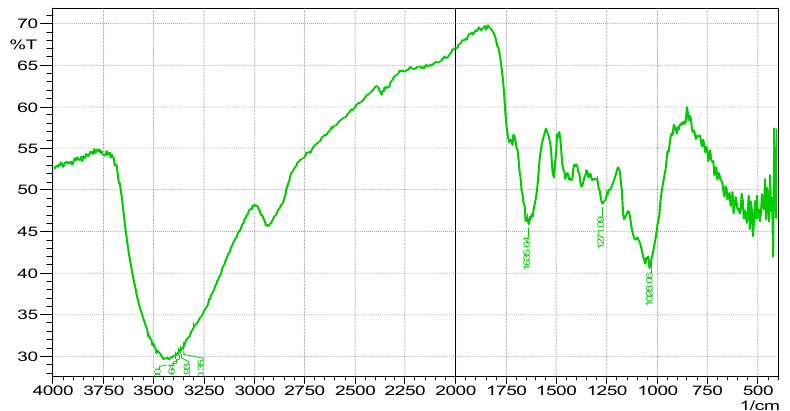
Fig. 3. FTIR spectrum of corn leaves adsorbent before adsorption.